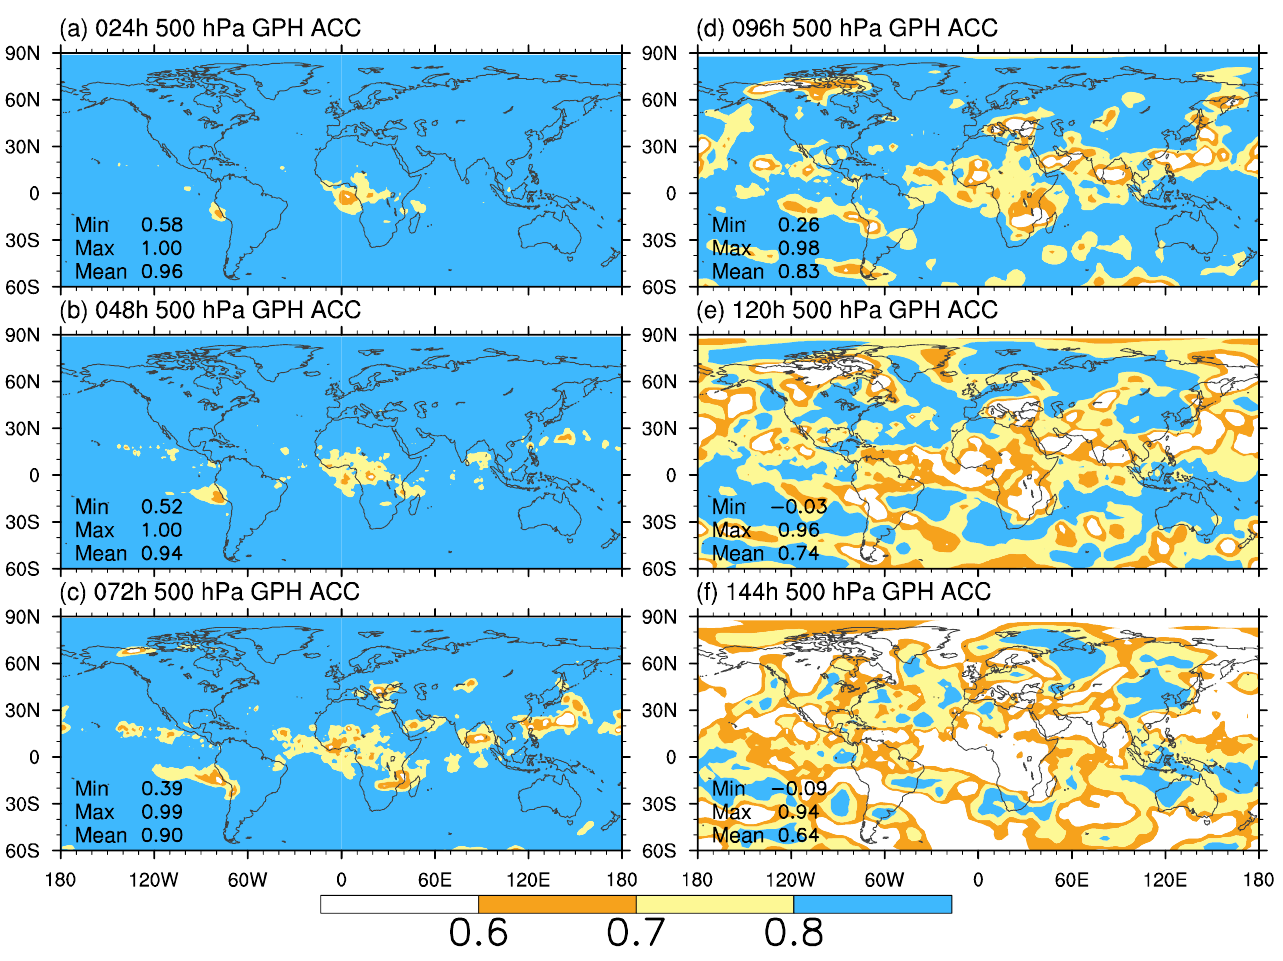
Figure 3. Spatial distribution of anomaly correlation coefficient (ACC) of 500 hPa geopotential height between GRAPES_NEW ( a ) 24 h forecast; ( b ) 48 h forecast; ( c ) 72 h forecast; ( d ) 96 h forecast; ( e ) 120 h forecast; ( f ) 144 h forecast results and ERA5 at the corresponding time.